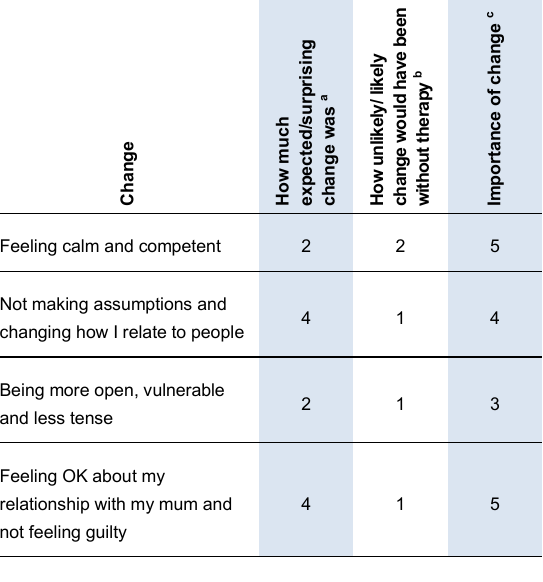
Table 2: Linda’s changes as identified in post-therapy Change